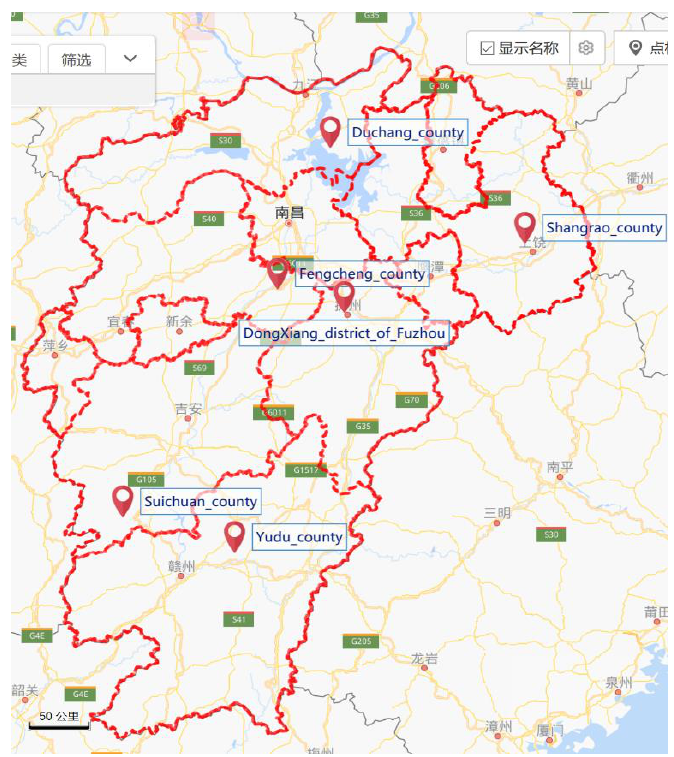
Figure 1. Distribution of sample counties in Jiangxi Province.